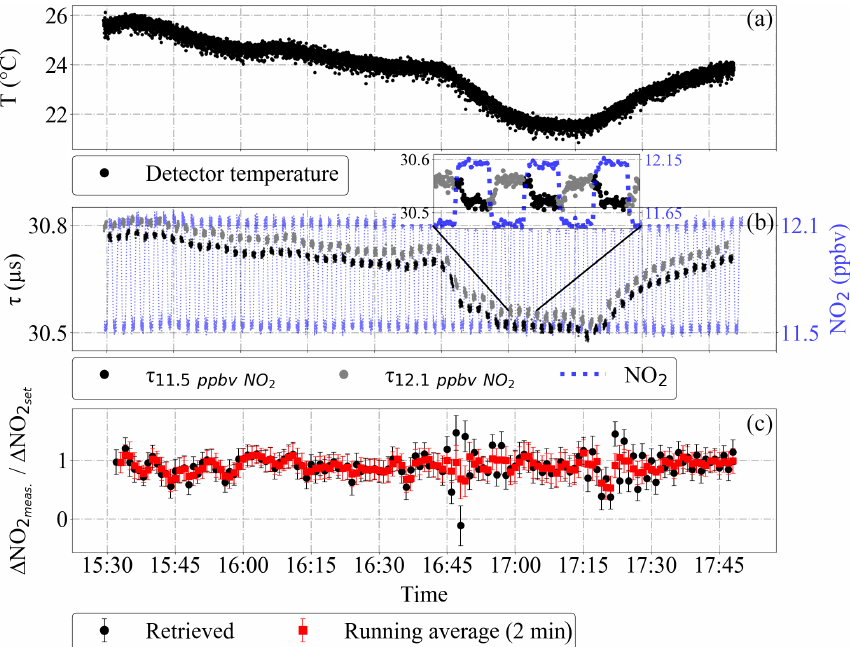
Figure 6. Effect of varying room temperature on the ring-down time τ and the (cid:49) NO 2 accuracy: (a) detector temperature, (b) τ for a modulated NO 2 flow and the corresponding NO 2 mixing ratios, and (c) ratio of the measured to the set (cid:49) NO 2 . The error bars in panel (c) are estimates of the total uncertainty of the retrieved (cid:49) NO 2 . The inset in panel (b) is a magnification of three modulation cycles. The first 20s of each signal after a change in the NO 2 mixing ratio are not used in the analysis (see